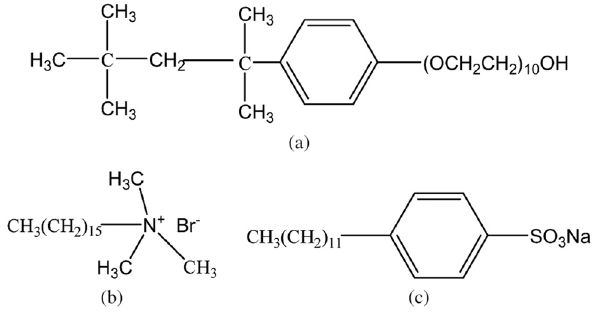
Figure 1: Chemical structures of surfactants: ( a ) TX - 10; ( b ) CATB; ( c ) SDBS [ 34 ]